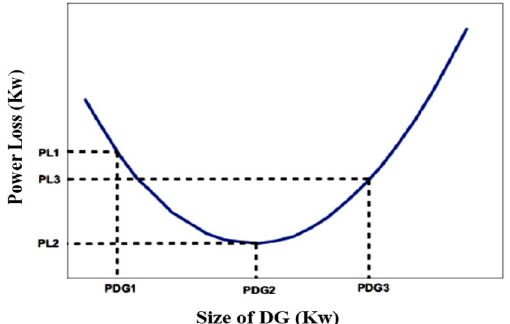
Fig. 1 Power loss curve according to DG capacity change